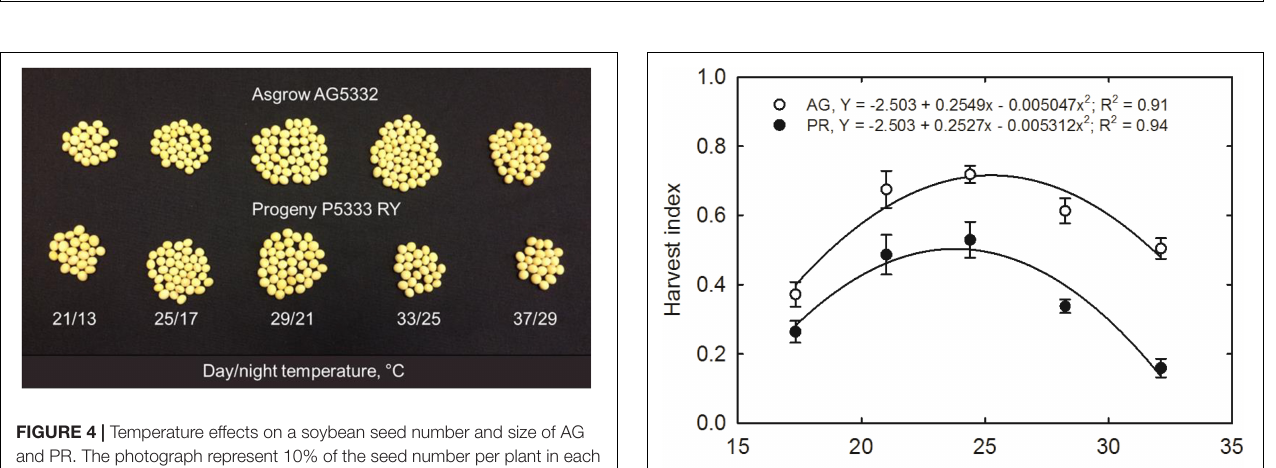
FIGURE 3 | Temperature effects on (A) pods number, (B) pods dry weight, (C) seed number, and (D) seed yield of soybean cultivars, AG with indeterminate, and PR with determinate growth habits, respectively. Measurements were taken at 120 days after sowing and 82 days after temperature treatment. SEM ± 12 observations are presented if the values are larger than the symbol size.